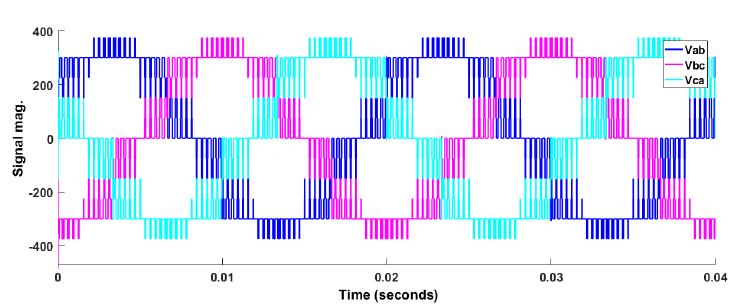
Figure 12. AHMMC output phase voltages at M f = 0.9 .